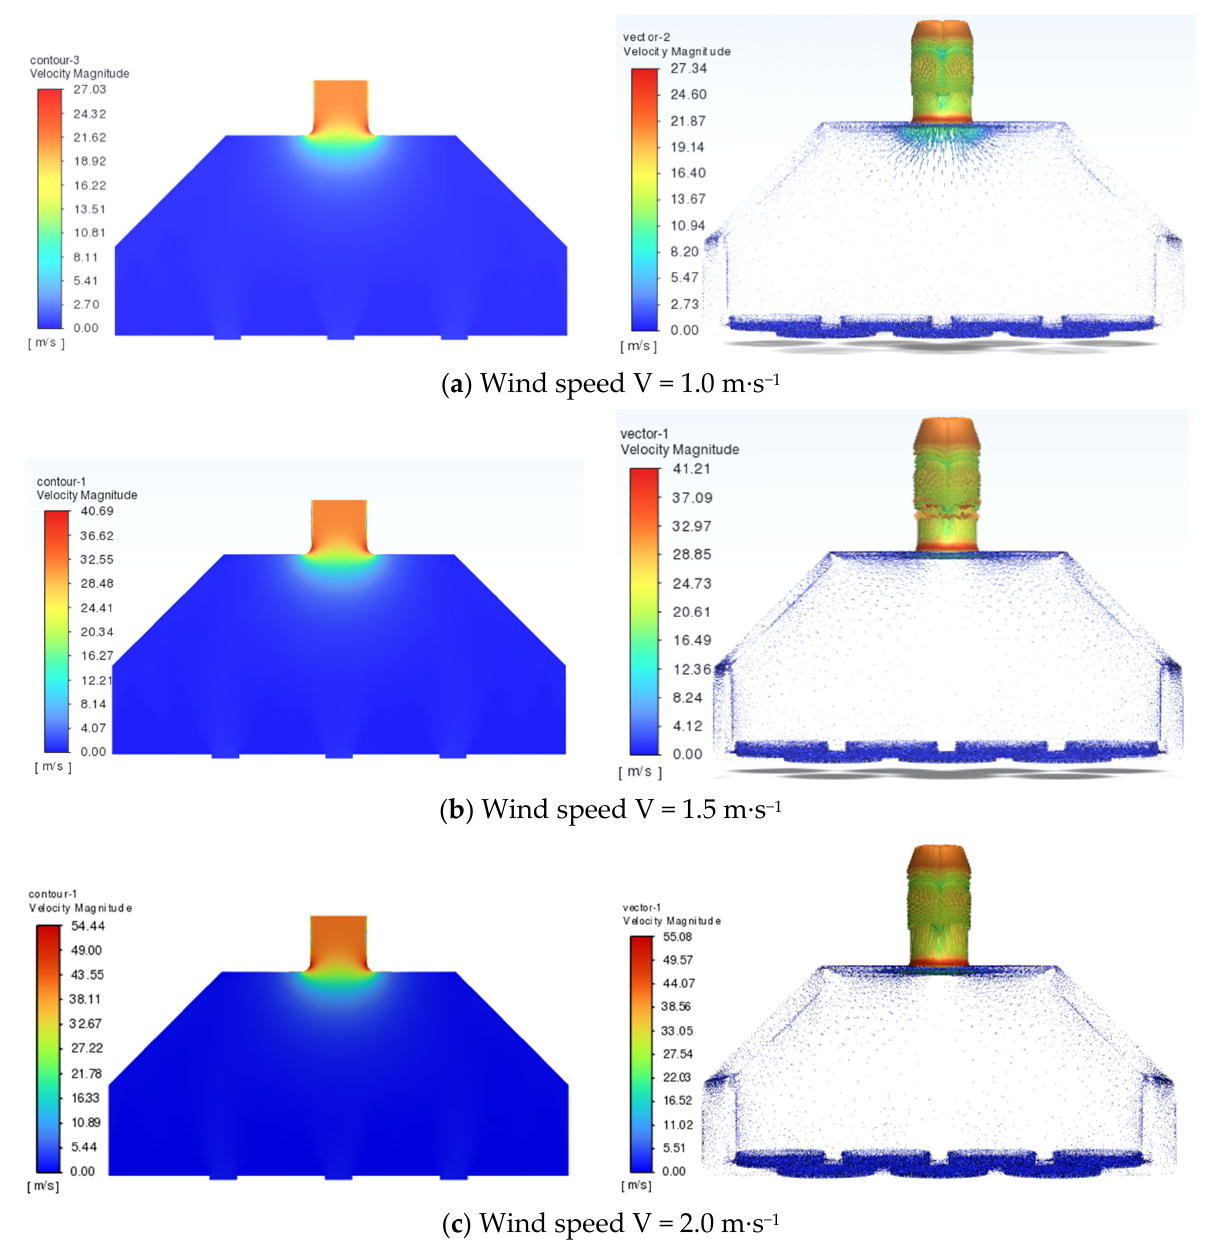
Figure 10. Velocity nephogram and velocity vector diagram under di ff erent wind speeds.